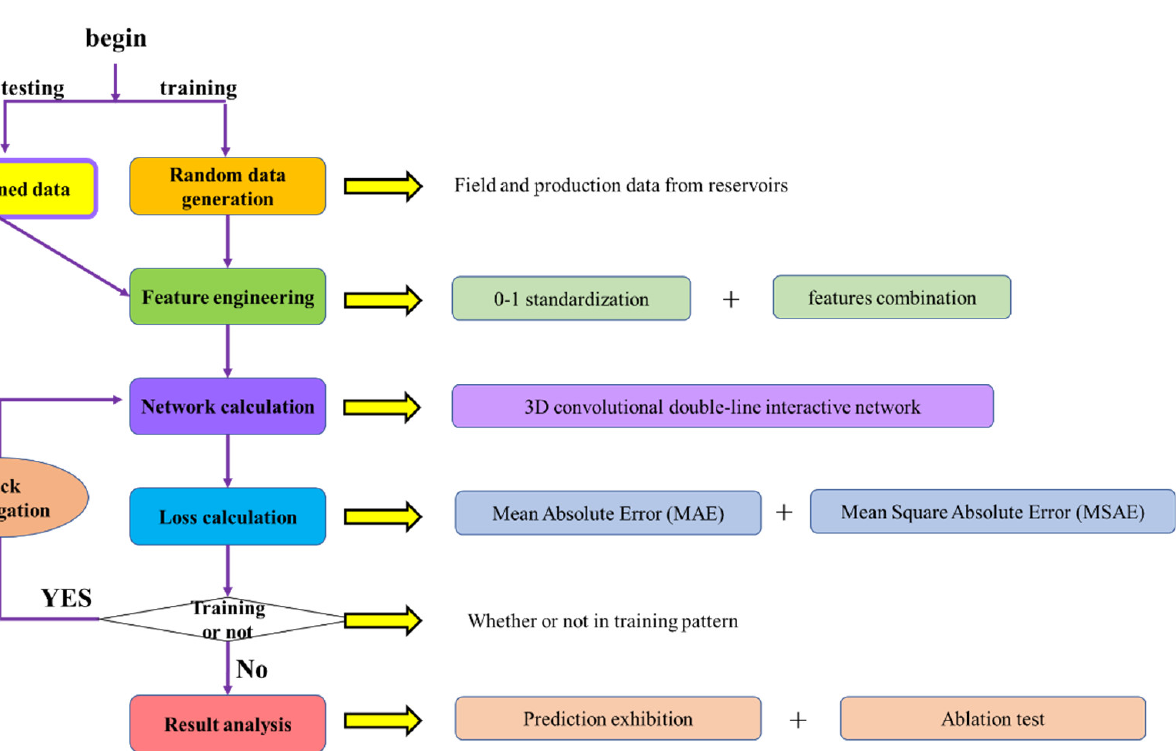
Figure 1. The workflow of our method and the content of each step.